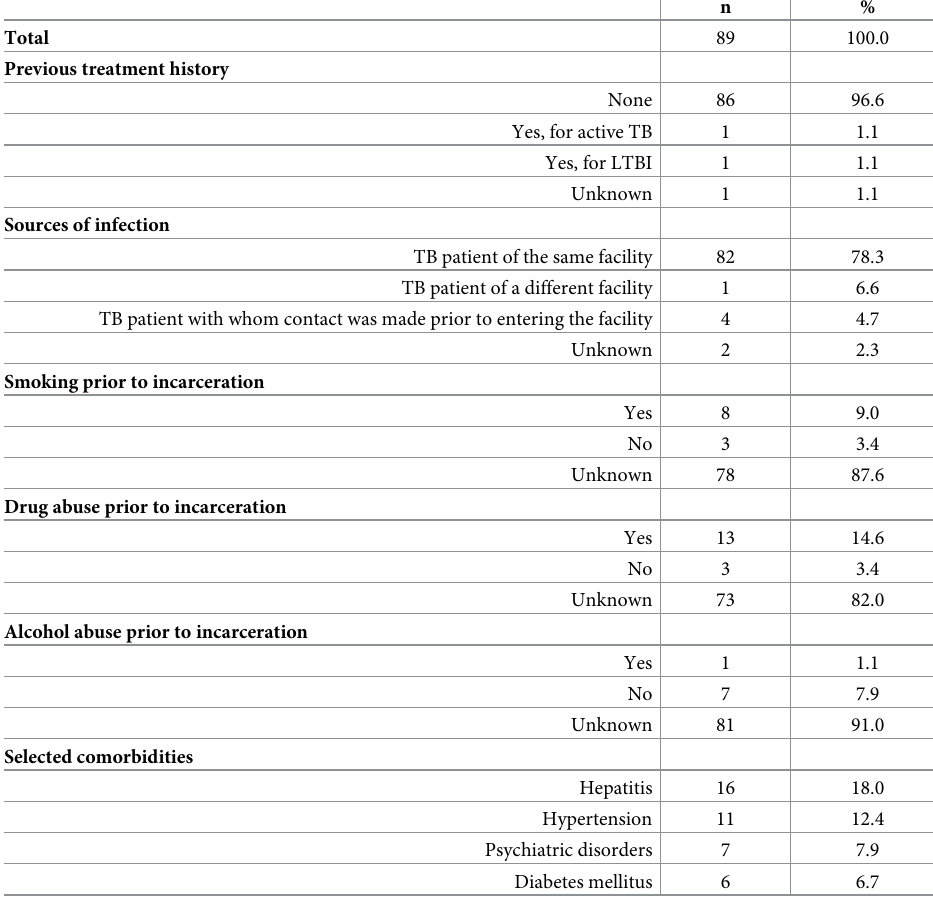
Table 3. Treatment history, sources of infection and possible risk factors of newly notified LTBI patients from correctional facilities, 2015–2016. Total 89